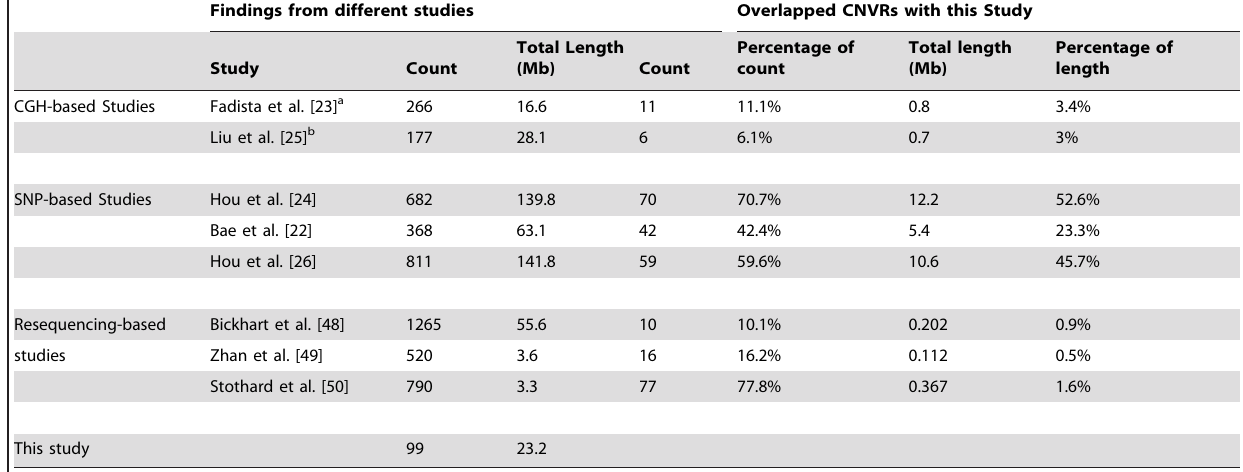
Findings from different studies Overlapped CNVRs with this